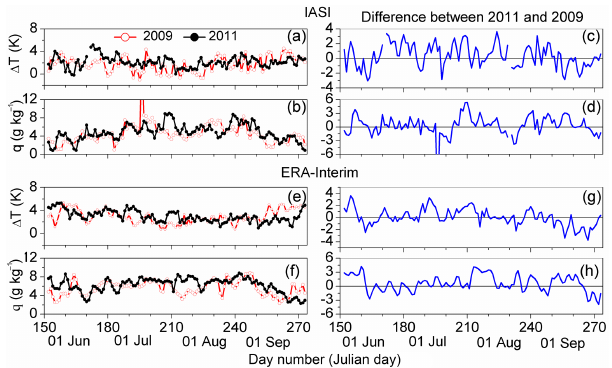
Figure 7. Time variations of (a) (cid:49)T and (b) q at 700hPa observed over the WAS during 2 contrasting years of 2009 and 2011 by using IASI measurements and ERA-Interim products (e, f) . Difference be- tween 2011 and 2009 observed in panel (c) (cid:49)T and panel (d) q at 700hPa for IASI and ERA-Interim products (g, h)